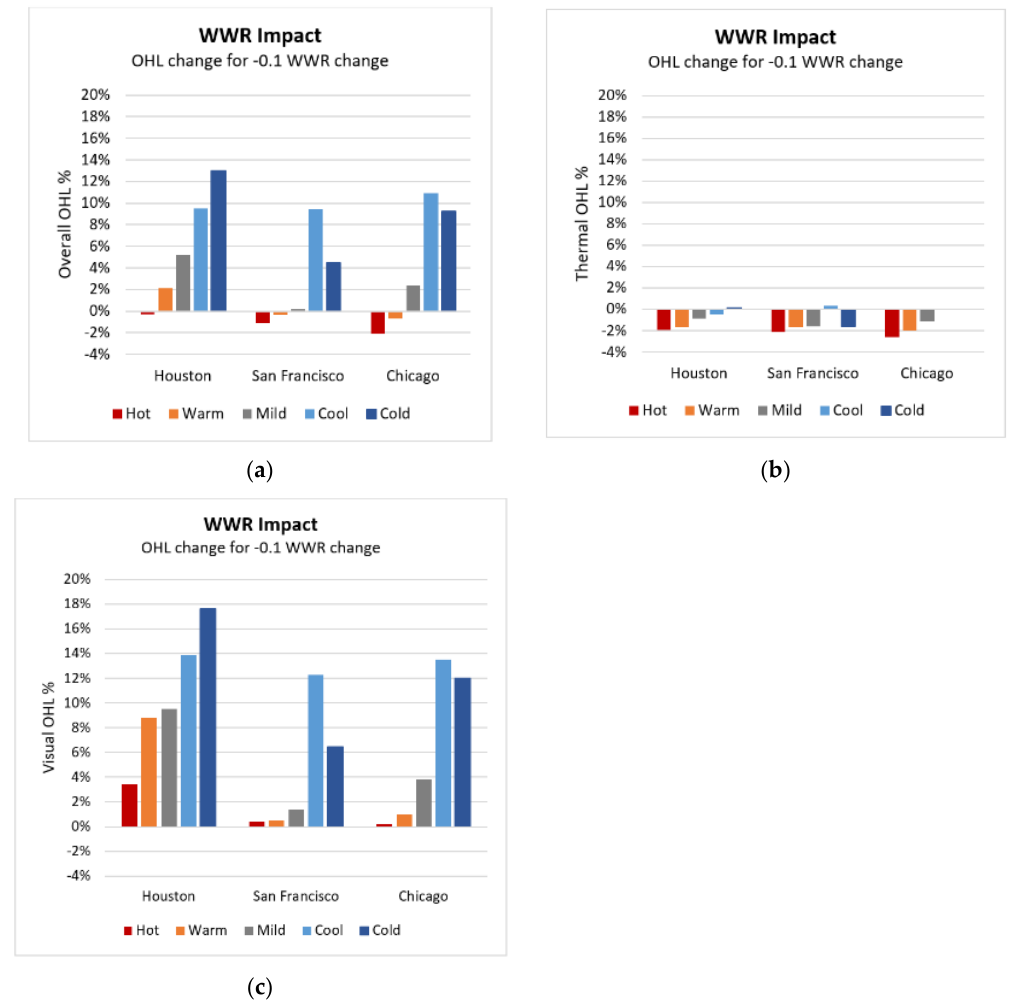
Figure 7. Impact of a 0.1 decrease in window-to-wall ratio (WWR) on overall ( a ), thermal ( b ), and visual ( c ) OHL.